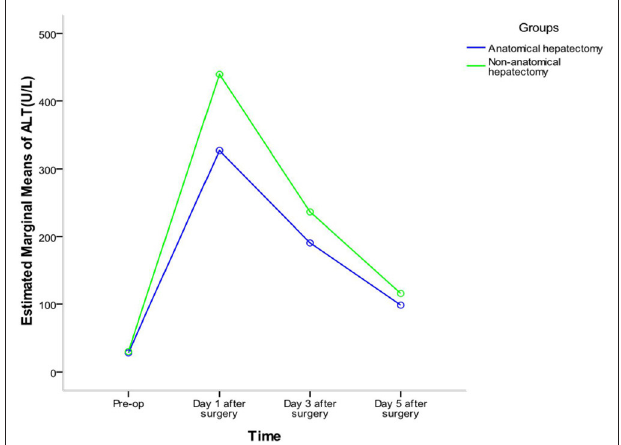
FIGURE 3 | Interactive profile of time factor and grouping factor.